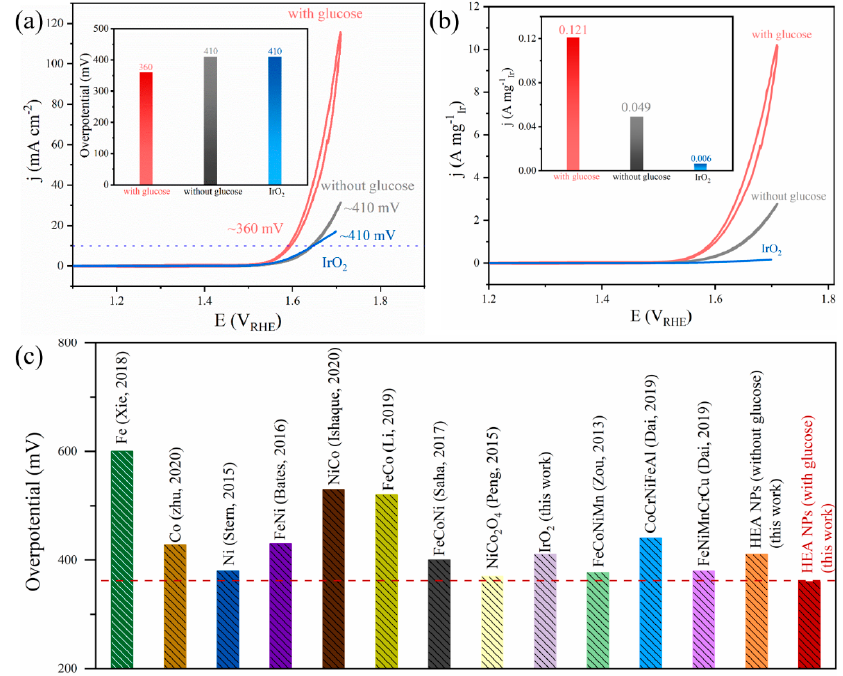
Figure 2. The CV curves of FeCoNiCuIr HEA NPs and commercial IrO 2 normalized by ( a ) electrode surface area and ( b ) Ir mass obtained in N 2 -saturated 1 M KOH at a scan rate of 5 mV s − 1 . Insets display ( a ) the comparison of overpotentials at 10 mA cm − 2 and ( b ) mass activities at 1.53 V RHE of both types of HEA NPs. ( c ) Comparison of the overpotentials at 10 mA cm − 2 for metals, bimetallic, trimetallic, commercial IrO 2 , and HEA NPs [31–40].